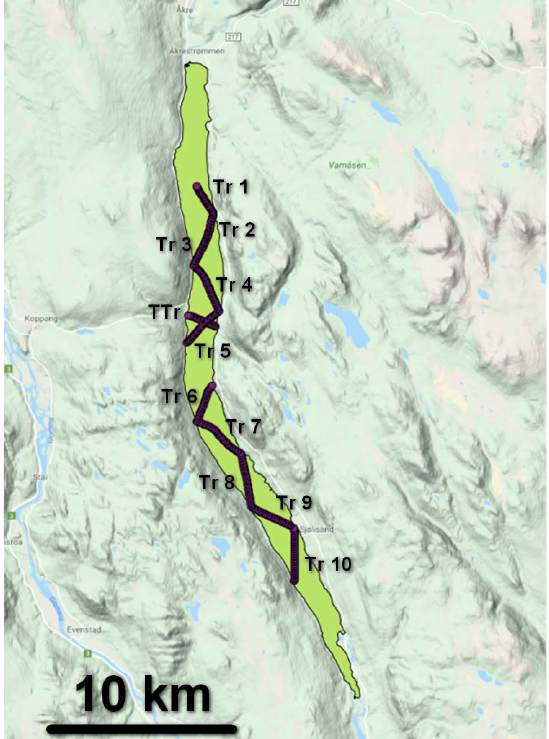
Figure 1. Map of Lake Storsjøen with transects Tr 1–10 recorded in May 2016, and the test transect TTr where six transects were performed to test the e ff ects of the ping repetition frequency (PRF) and pulse duration (PD) on density estimates, in September